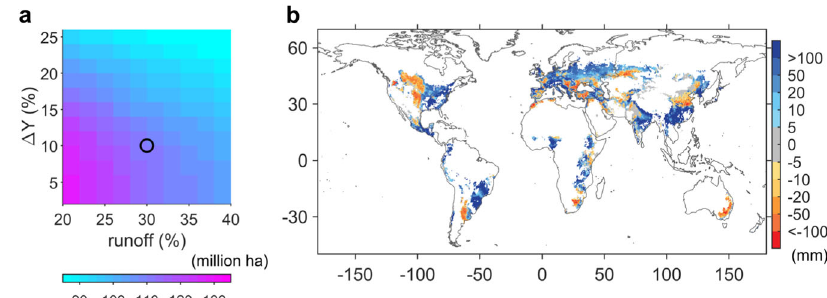
Fig. 4 Relationship between irrigation demand estimated from the reanalysis for contemporary rainfed croplands of wheat and maize and available runoff resources. a The amount of rainfed crop area when irrigation demand cannot be met with available runoff resources, according to different minimum threshold of Δ Y ( y -axis) and maximum threshold of runoff consumption ( x -axis). b The spatial distribution of the difference between irrigation demand and available runoff resources. The spatial pattern is determined with the minimum threshold of Δ Y for demanding irrigation is 10% and the maximum usage of runoff is 30% (corresponding to the black circle in a ). See Supplementary Fig. 5 for spatial pattern of different thresholds of